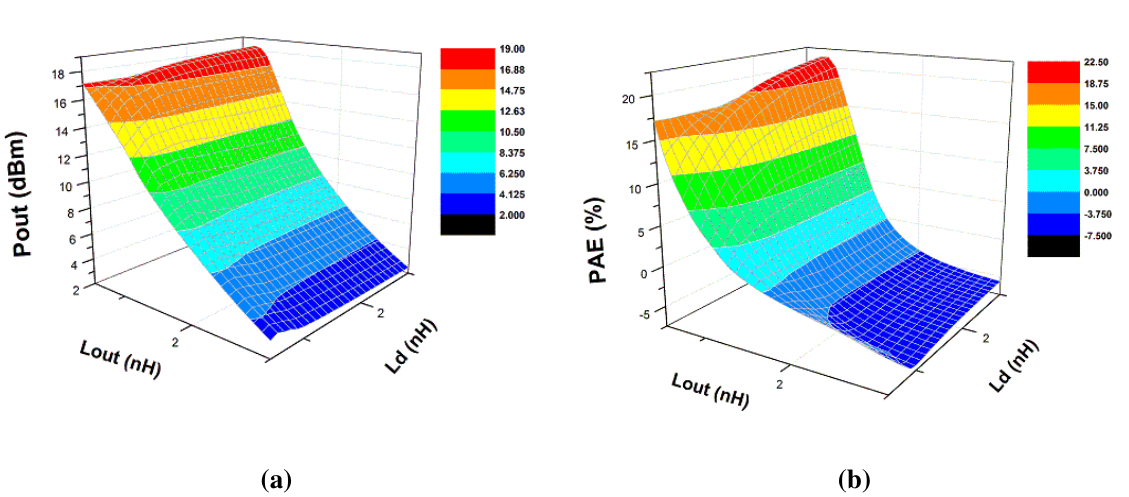
Figure 7. ( a ) Output inductor and RF choke versus output power; ( b ) output inductor and RF choke versus power-added efficiency.